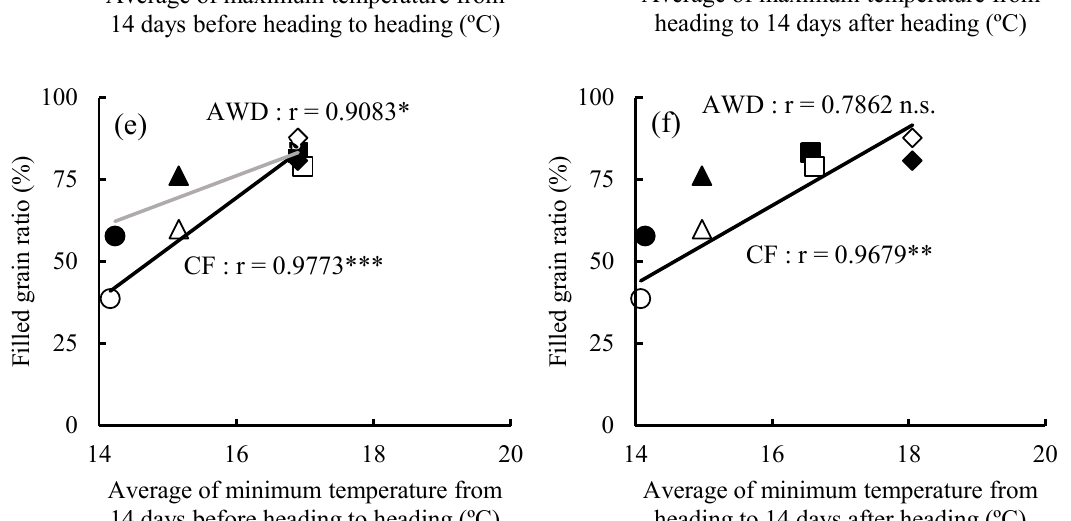
Figure 3. Relationship between filled grain ratio and mean ( a , b ), maximum ( c , d ), and minimum ( e , f ) temperatures from 14 days before heading to heading ( a , c , e ) and from heading to 14 days after heading ( b , d , f ) in Basmati 370 grown under continuous flooding (CF) and alternate wetting and drying (AWD) conditions in 2014 ( ● , ○ ), 2015 ( ■ , □ ), 2016 ( ▲ , △ ), and 2017 ( ◆ , ◇ ). Open symbols are CF. Closed symbols are AWD. The black lines represent data from CF, and the gray line represents AWD. *, **, and *** indicate significance at p < 0.05, p < 0.01, and p < 0.001, respectively. n.s. indicates not significant.